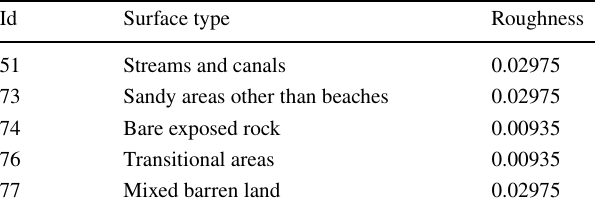
Table 1 Mapping table values in GSSHA model used in a 2-D rout- ing of surface overland flow